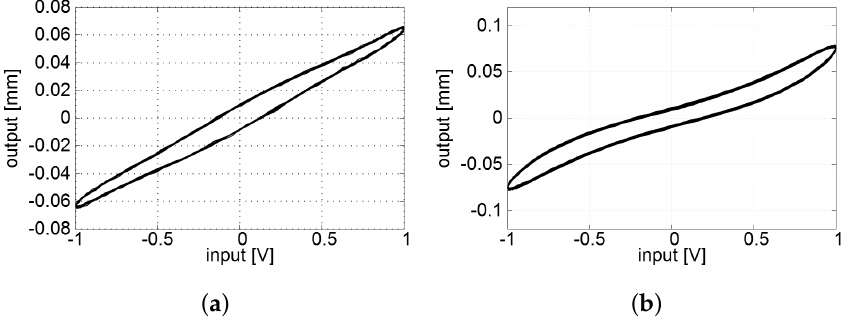
Figure 5. Actuator responses to ( a ) 14 Hz and ( b ) 23 Hz sinusoidal inputs plotted in the input/output plane.